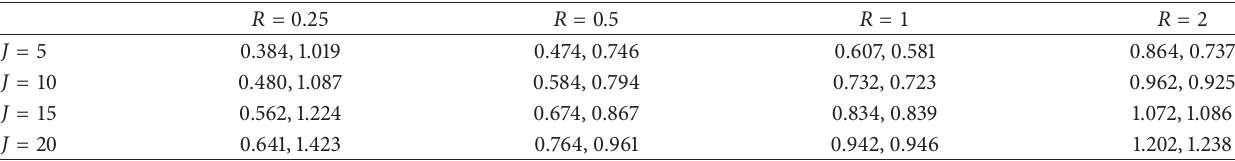
Table 1: Sensitivity to the observation interval and the observation error. The first value of each pair indicates the RMSE of SELKF, while the second one is the RMSE of